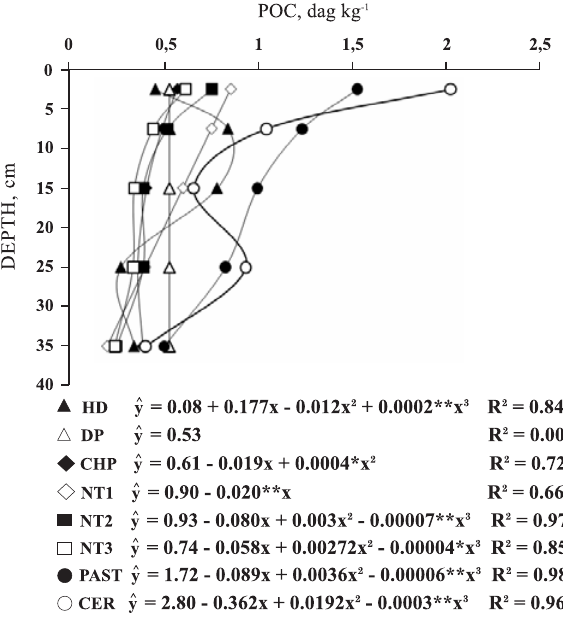
Figure 1. Distribution of levels of particulate organic carbon (POC) in the profiles of the different management systems according to the complete regression model of non-orthogonal polynomials. * : significant at 5 %; ** : significant at 1 % by the F